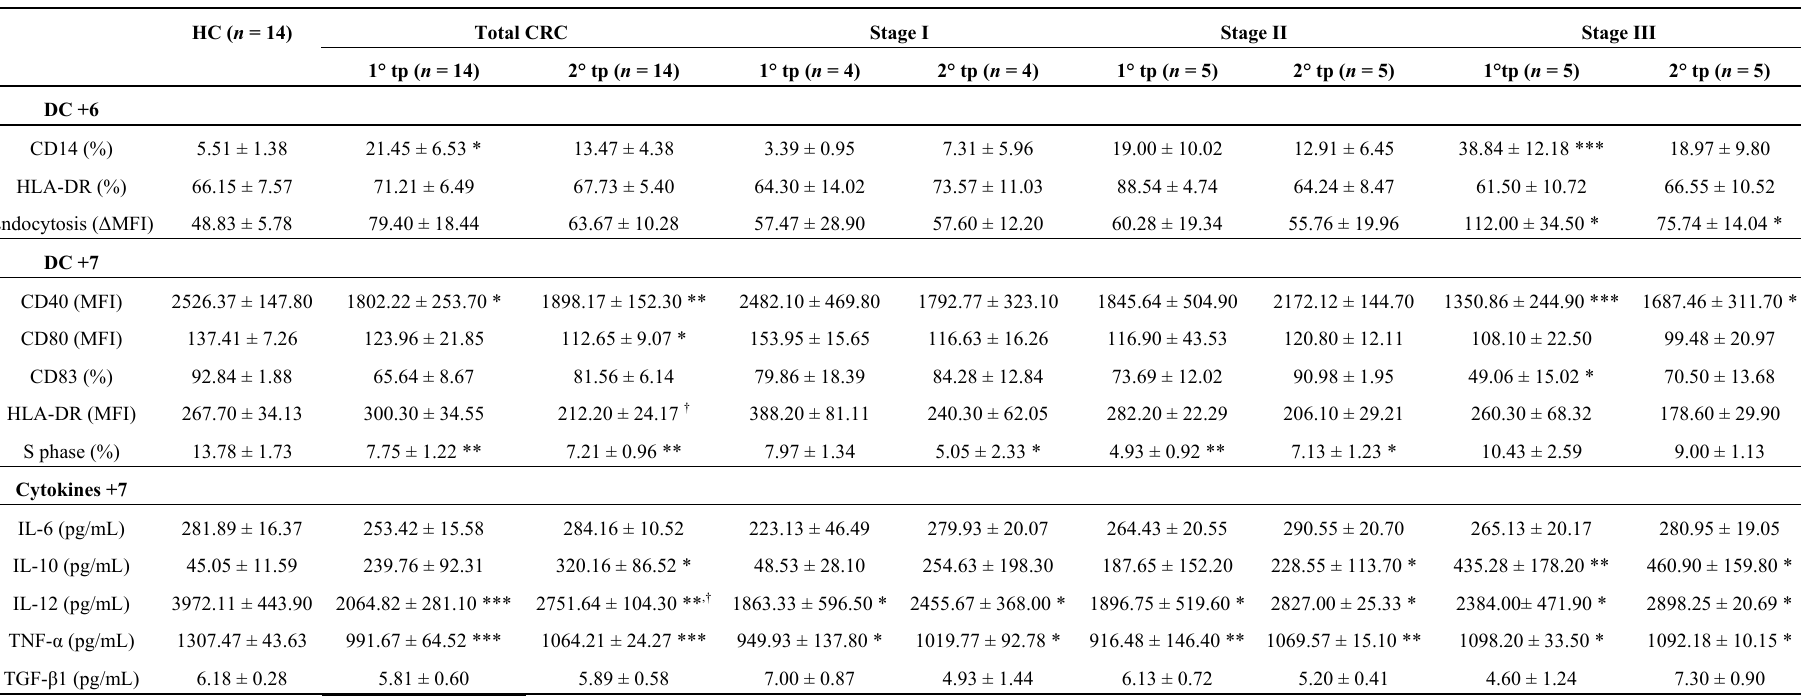
Table 2. Comparison of data from healthy controls and post- and pre-surgical colorectal cancer